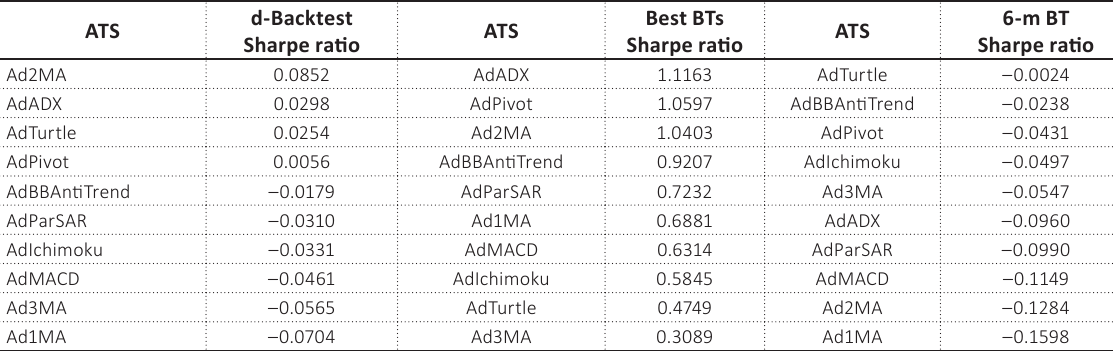
Table B2. Total results for Sharpe